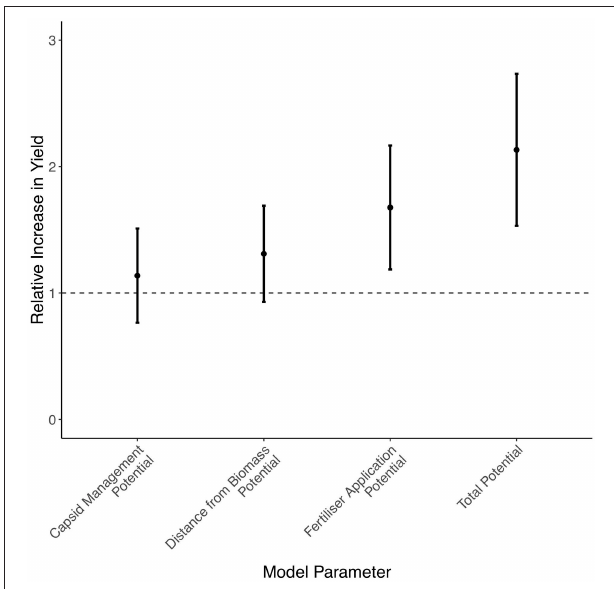
FIGURE 2 | Potential community-level increase in yield. Using the identified factors influencing per tree yields, potential yield increases were calculated per farm and proportional increases in yield at the community level estimated. Ninety-five percent confidence intervals are